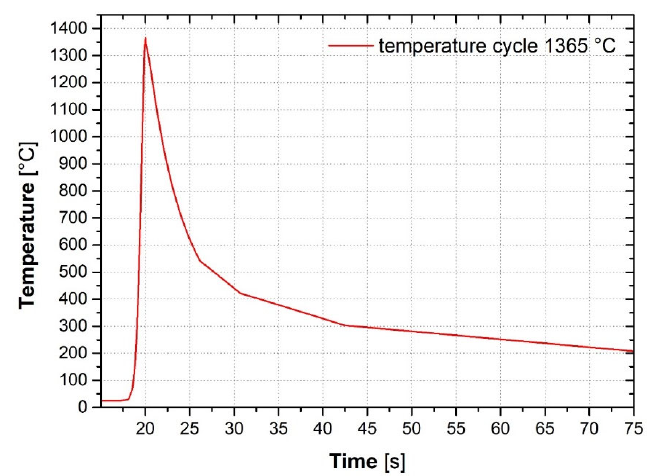
Figure 4. Temperature cycle used for physical simulations (1365 °C).